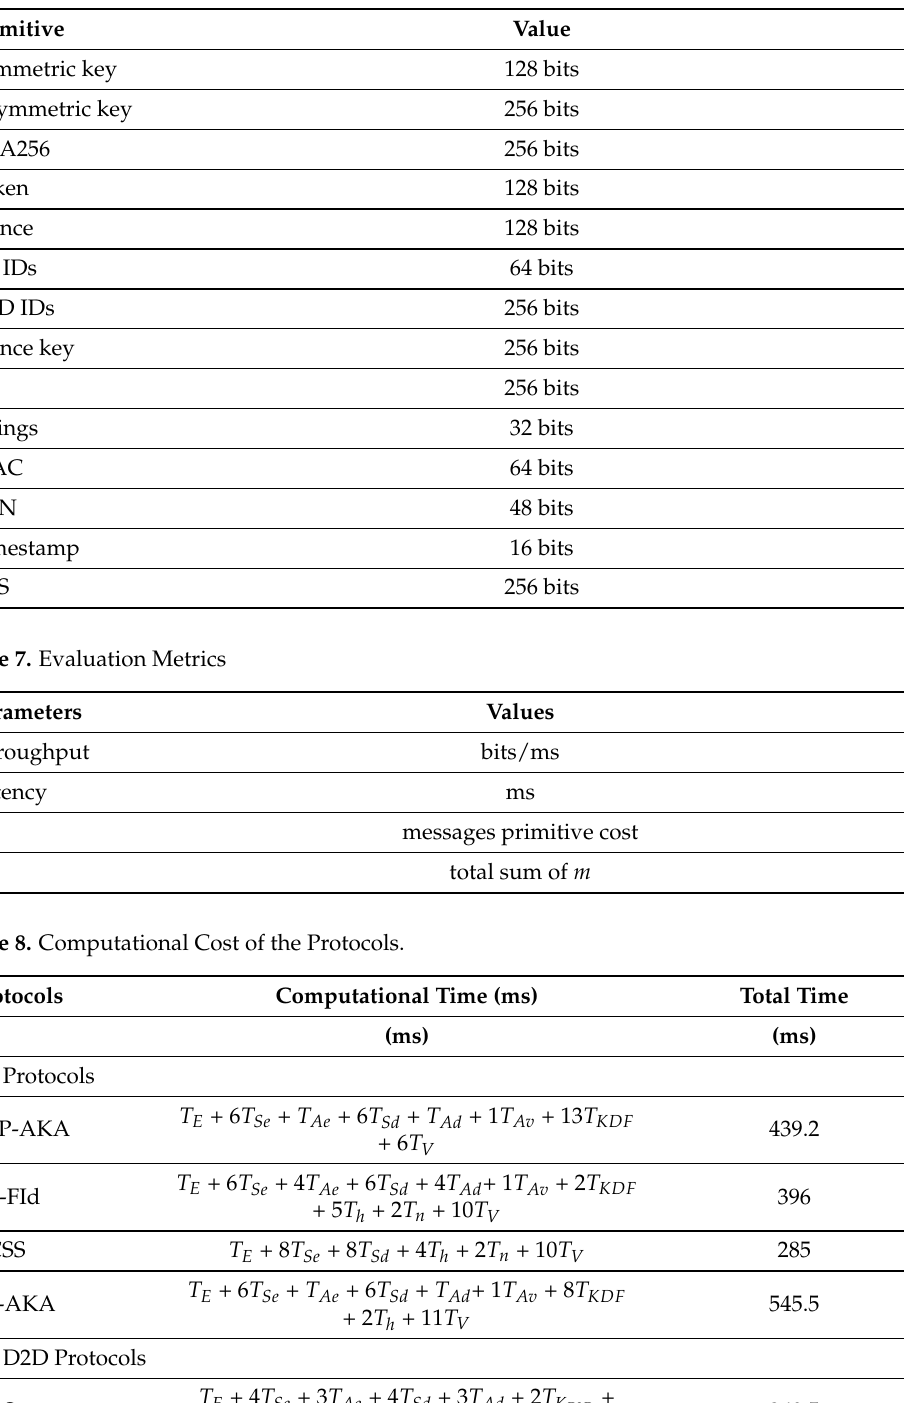
Table 6. Cryptographic Primitive Size.